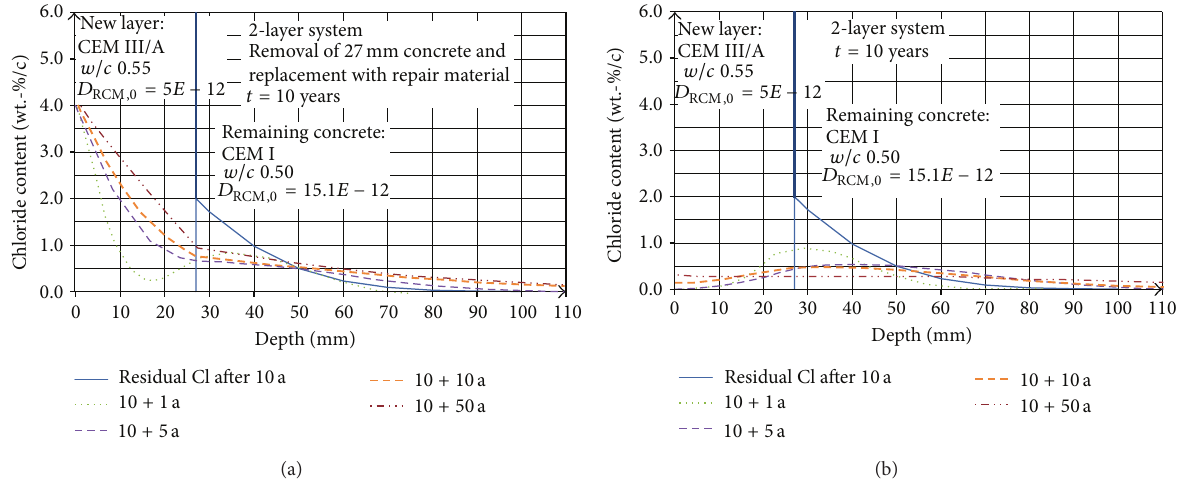
Figure 8: FE simulation of chloride ingress and redistribution in a 2-layer system (a): both residual and external chloride ions are present and (b): redistribution of residual chloride ions.